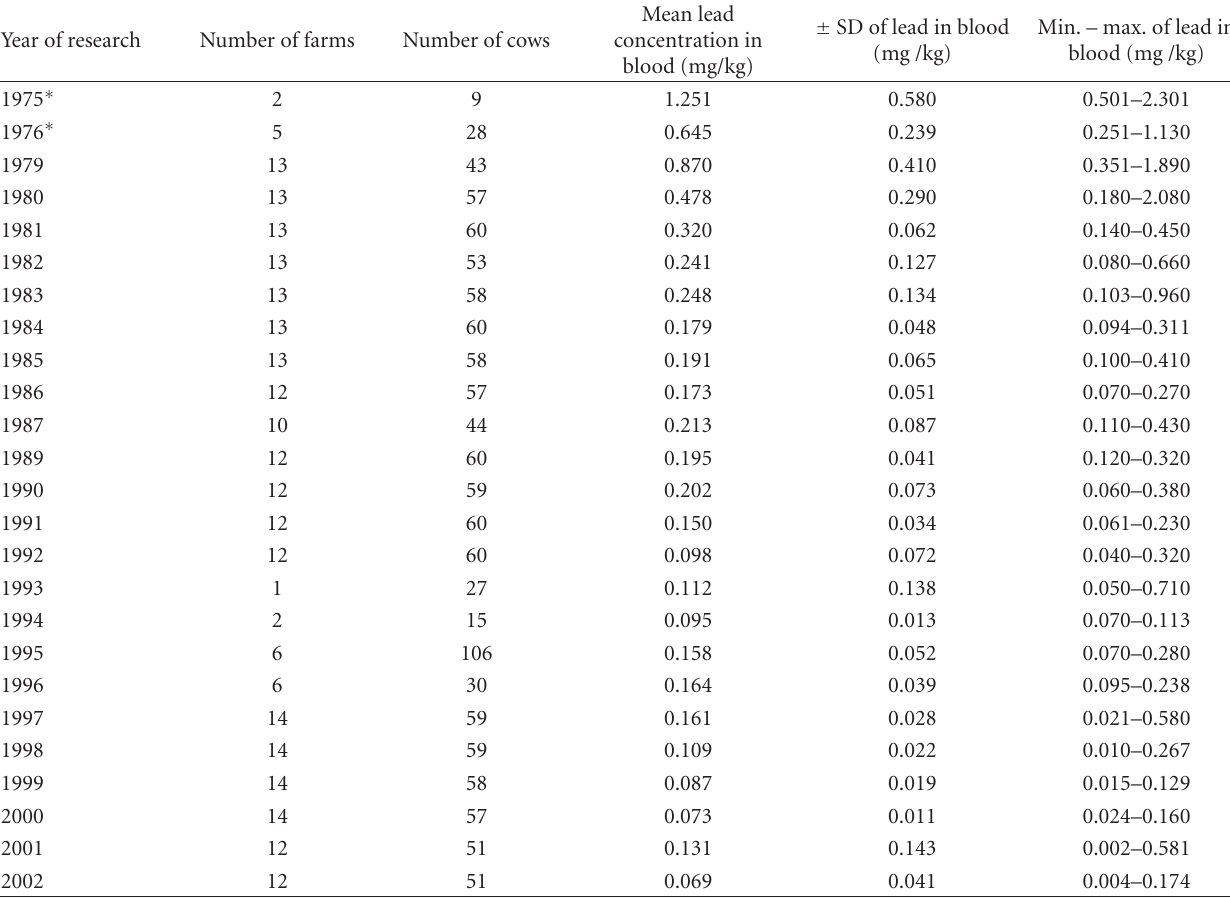
Table 4: Mean, standard deviation (SD), and minimal-maximal concentrations of lead in the blood of cows before (1975-1976) and after the installation of bag filter system.